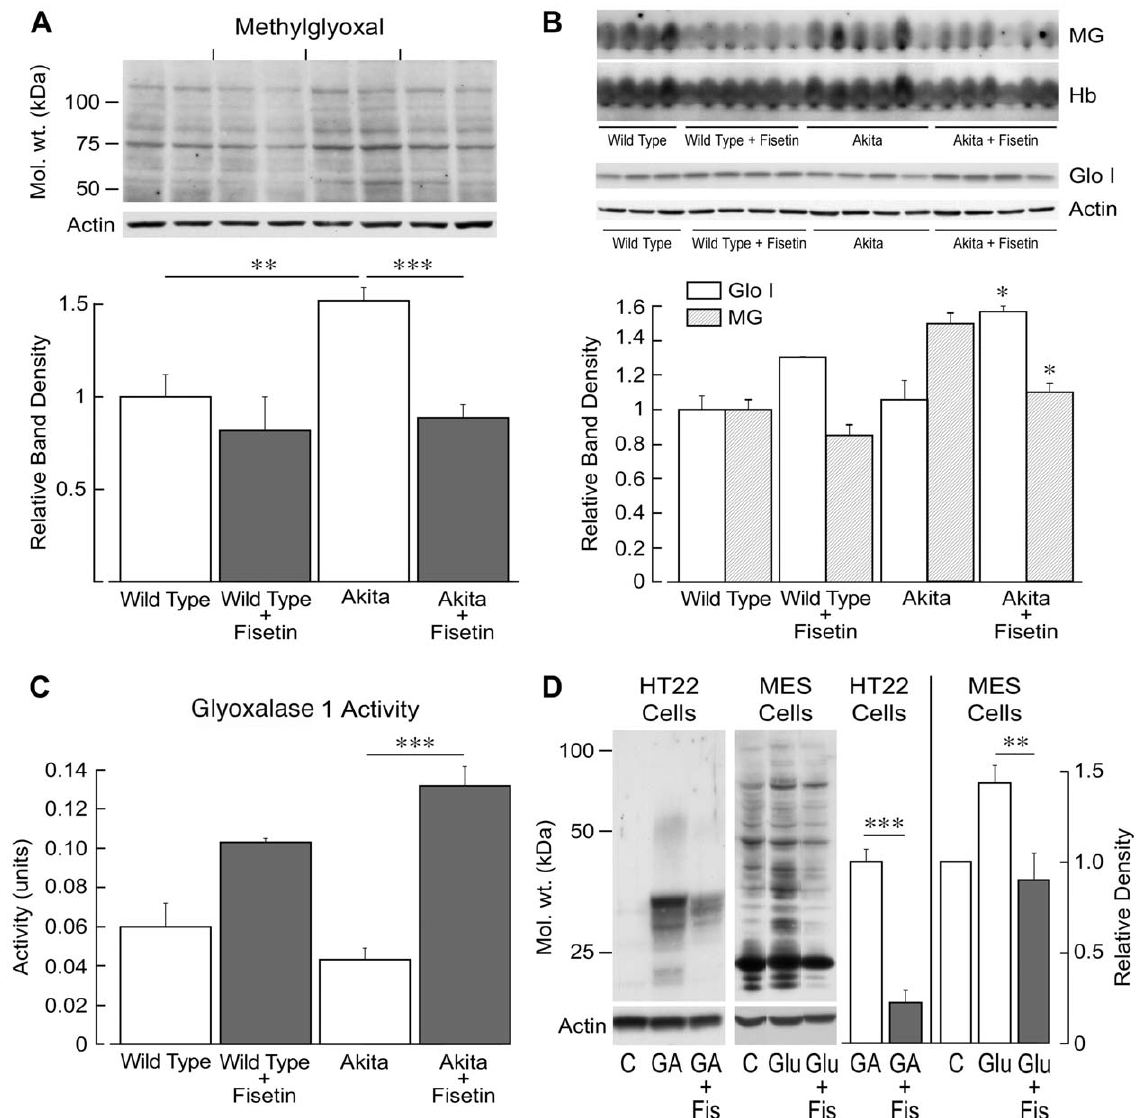
Figure 5. Fisetin reduces MG-dependent protein glycation in the kidney and blood. (A) Kidneys were homogenized in PBS containing phosphatase and protease inhibitors and equal amounts of protein were analyzed by SDS-PAGE and Western blotting with an antibody to MG and actin as a loading control. The entire gel as shown was scanned and the total density normalized to actin. Four to 6 animals were used per group for quantifying band densities with 2 representative kidneys per group shown. (B) Either whole blood was assayed by Western blotting with an anti-MG antibody or kidney tissue with an anti-glyoxylase 1 antibody. The major MG-glycated protein in blood was hemoglobin (shown) and its loading control is total hemoglobin ( a and b ). Glyoxylase 1 expression was normalized to actin. (C) The activity of glyoxylase 1 was measured and is expressed in units. One unit is the amount of activity required to produce 1 mmole of S-D-lactoylglutathione/min/mg protein. ***( p , 0.001), **( p , 0.01) and *( p , 0.05) indicate significantly different from wild type or Akita alone as determined by ANOVA followed by Tukey’s post test. (D) Exponentially dividing HT22 cells were exposed to 5 mM glutamic acid (GA) with or without 2 m M fisetin (Fis) for 8 h. The cells were lysed in SDS sample buffer and equal amounts of protein were analyzed by SDS-PAGE and Western blotting with an antibody to MG and actin as a loading control (n=3). The kidney mesangial cell line MES13 was grown in 5 mM glucose (glu) (C is control) and some cells transferred to 25 mM glucose plus or minus 10 m M fisetin (Fis) for 8 h. The cells were lysed is SDS sample buffer and equal amounts of protein were analyzed by SDS-PAGE and Western blotting with an antibody to MG and actin as a loading control (n=3). For both cell lines, the entire gels as shown were scanned and the total densities normalized to actin. Significant differences were determined by ANOVA followed by Tukey’s post test. ** p , 0.01; *** p ,